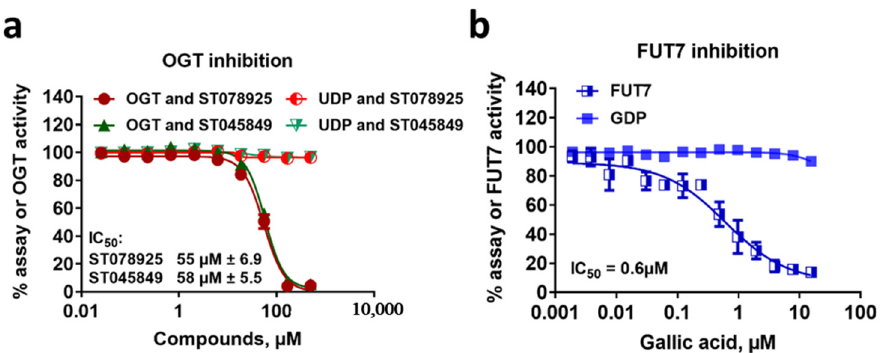
Figure 8. Detection of glycosyltransferase inhibitor effect using bioluminescent nucleotide assays. ( a ) Inhibition of OGT by two compounds detected with UDP-Glo assay. ( b ) Inhibition of FUT7 Gallic acid detected with GDP-Glo assay. To control for assay reagent inhibition with the compounds, a titration of the compounds was performed in the presence of the nucleotide with no enzyme. Curve fitting and IC 50 value determinations were performed using GraphPad Prism ® version 9, sigmoidal dose-response (variable slope) software. Reactions were performed in duplicates, and the results shown are means ± standard